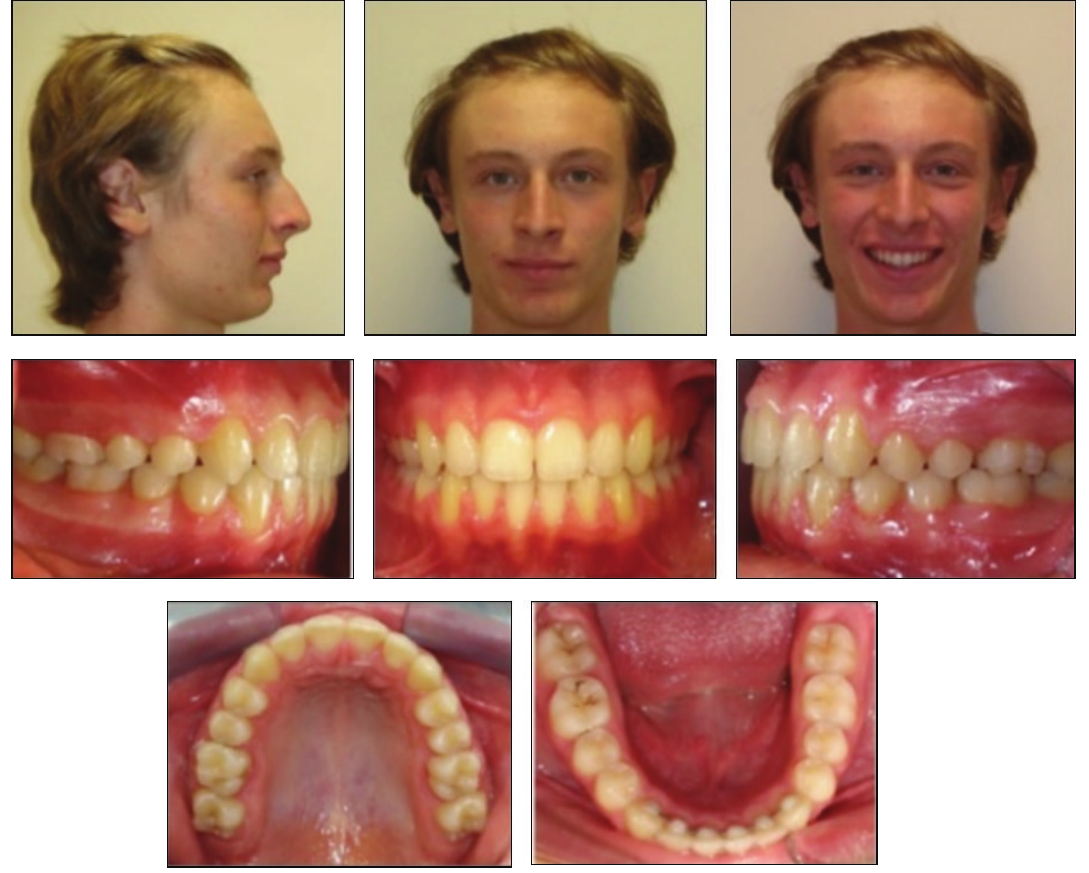
Figure 4: Posttreatment facial and intraoral photographs.